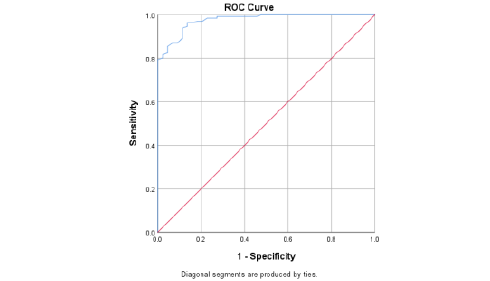
Figure (3 ): ROC curve for transcutaneous chest bilirubin values predicting TSB value >10mg/dl (area under the curve